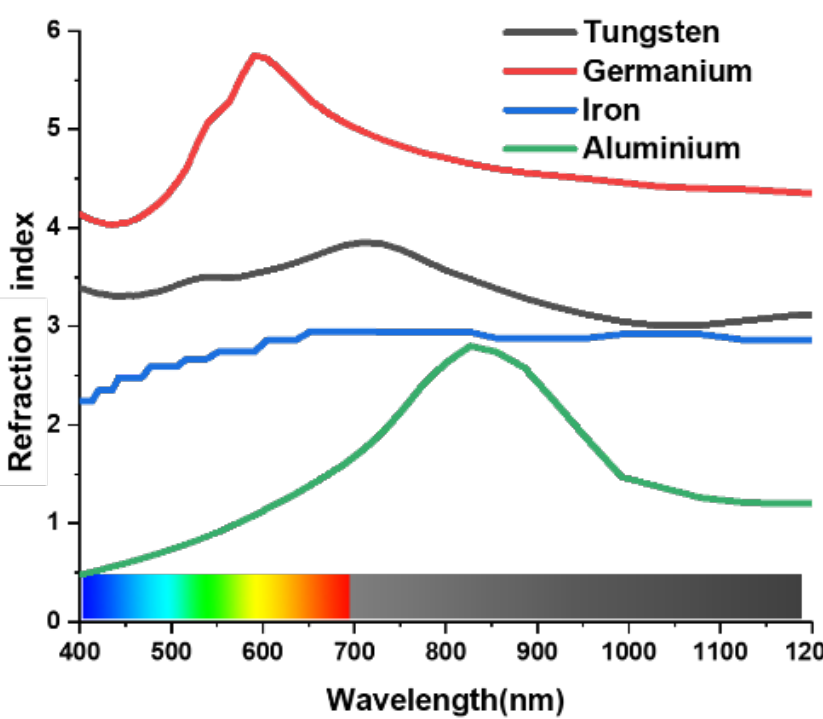
Figure 5. Refraction index of Tu, Ge, Al, and iron.